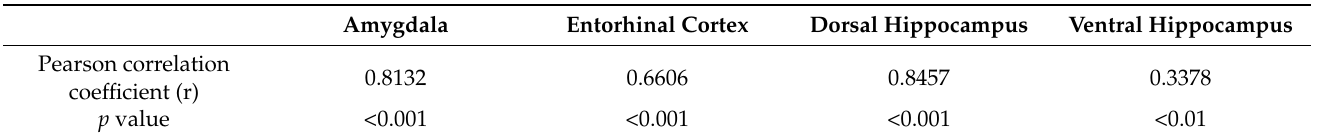
Table 2. Results from the Pearson’s correlation analysis of data obtained from the double immunoflu- orescence analysis.